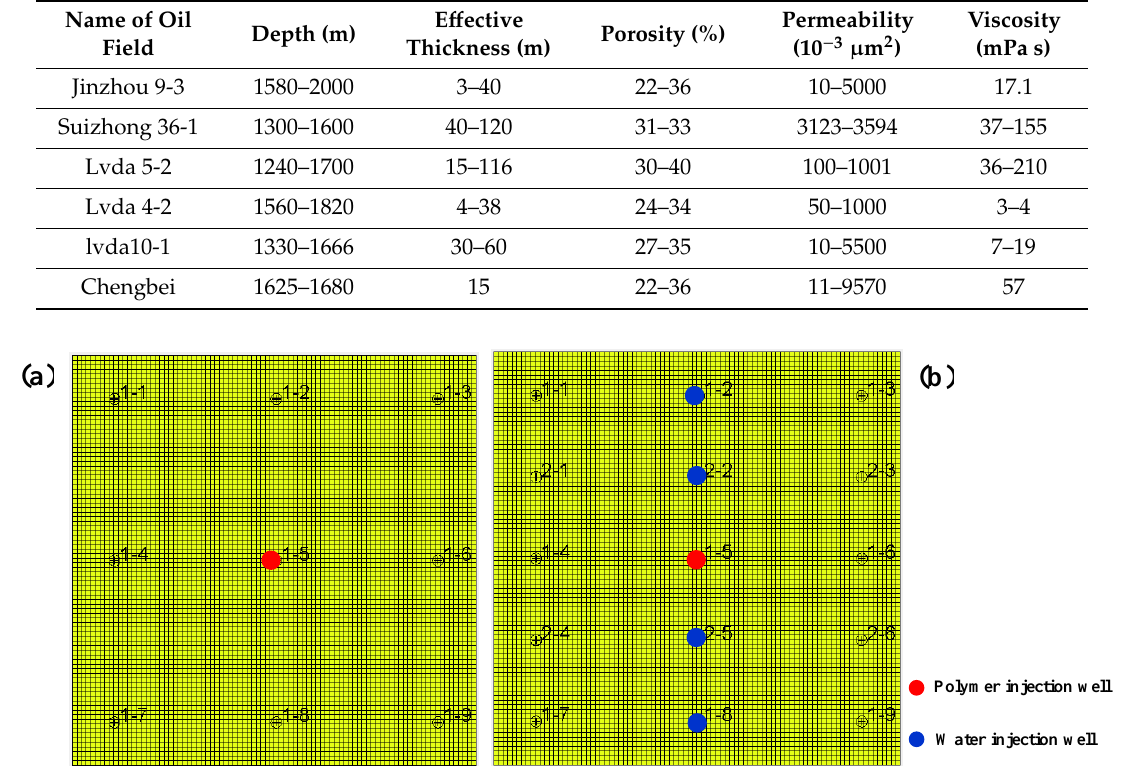
Figure 1. The schematic diagram of the Jinzhou 9-3 oilfield. ( a ) Inverted nine-spot well pattern and ( b ) Row well pattern.